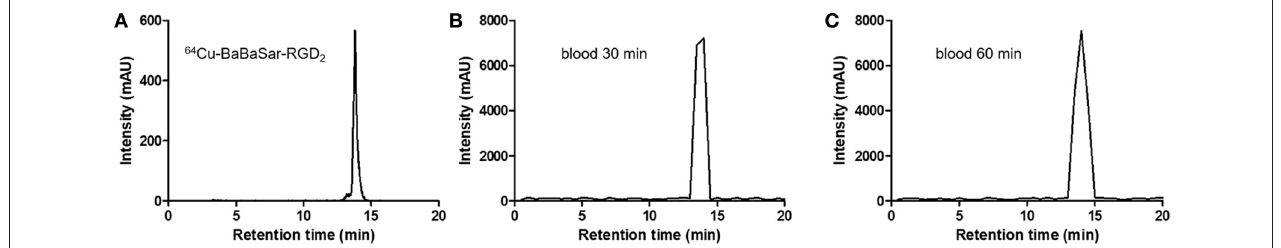
FIGURE 4 | (A) Standard radiotrace chromatogram of 64 Cu-BaBaSar-RGD 2 . Analysis of the blood samples drawn at 30min (B) and 60min (C) after injection of 64 Cu-BaBaSar-RGD 2 in the